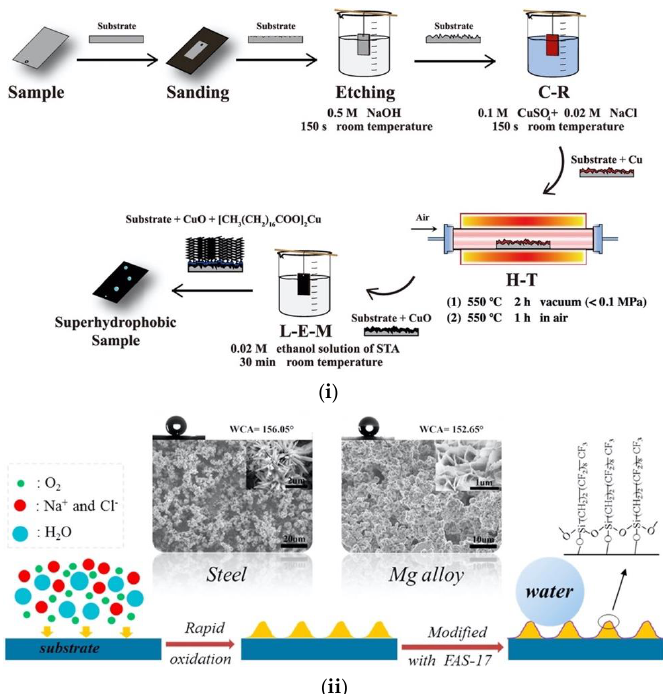
Figure 7. ( i ) The process flow for the leaf-like superhydrophobic coating. Reproduced with permission from [63]. ( ii ) Schematic representation of the method to fabricate superhydrophobic surfaces on steel and AZ31B magnesium alloy, as presented by Li Wang et al. [64]. SEM images of the topography created in both substrates are also provided as insets. Reproduced with permission from